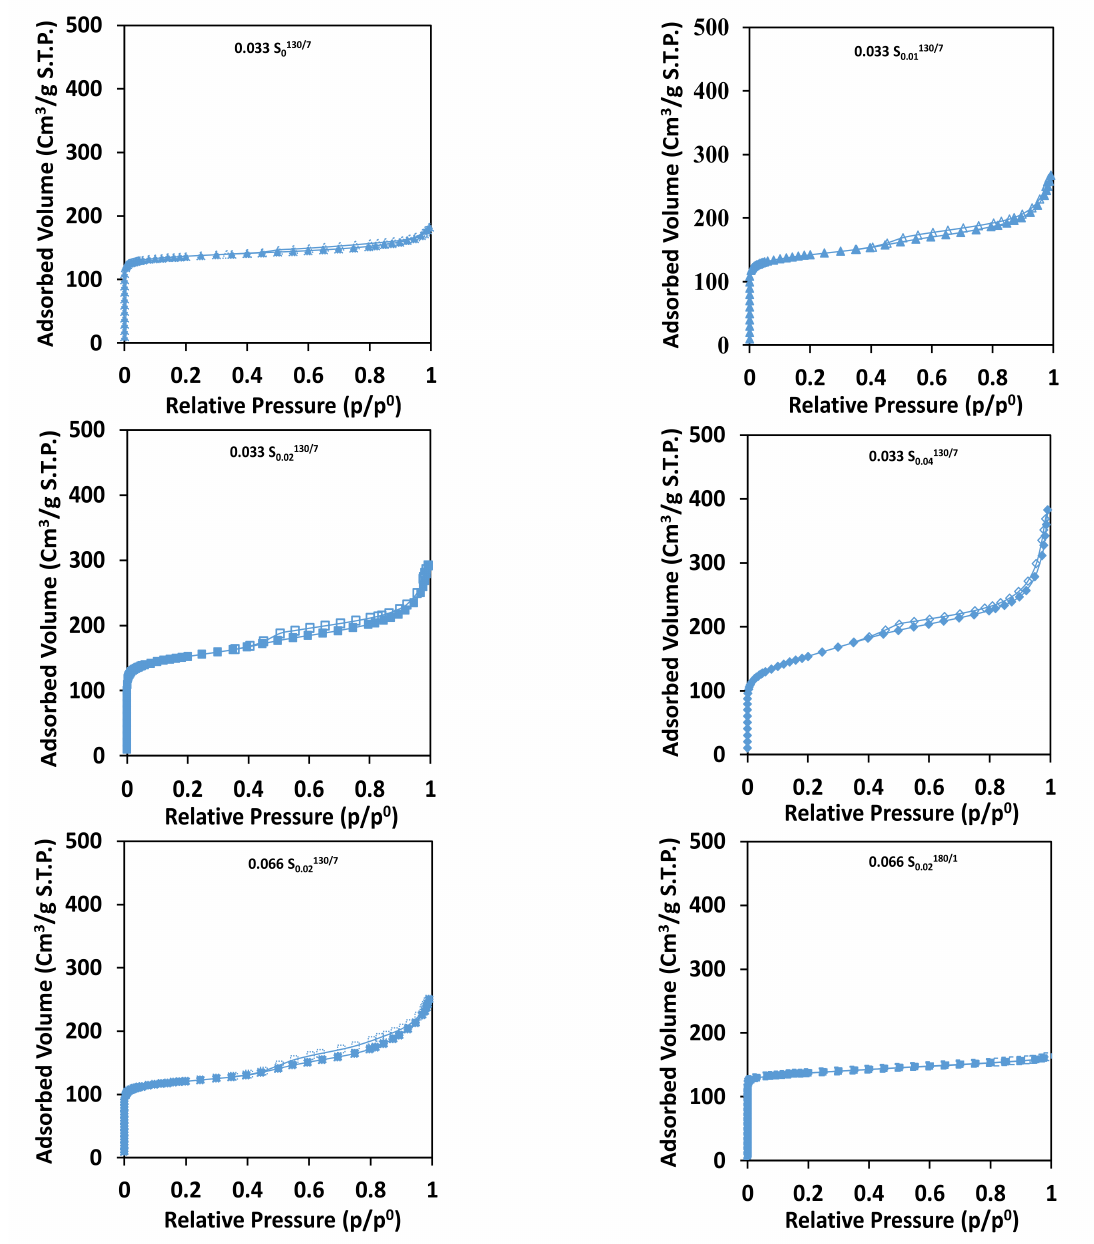
Figure 3. N 2 adsorption (solid symbols) and desorption (open symbols) isotherms done at − 196 ◦ C of the calcined zeolites obtained in the absence or in the presence of